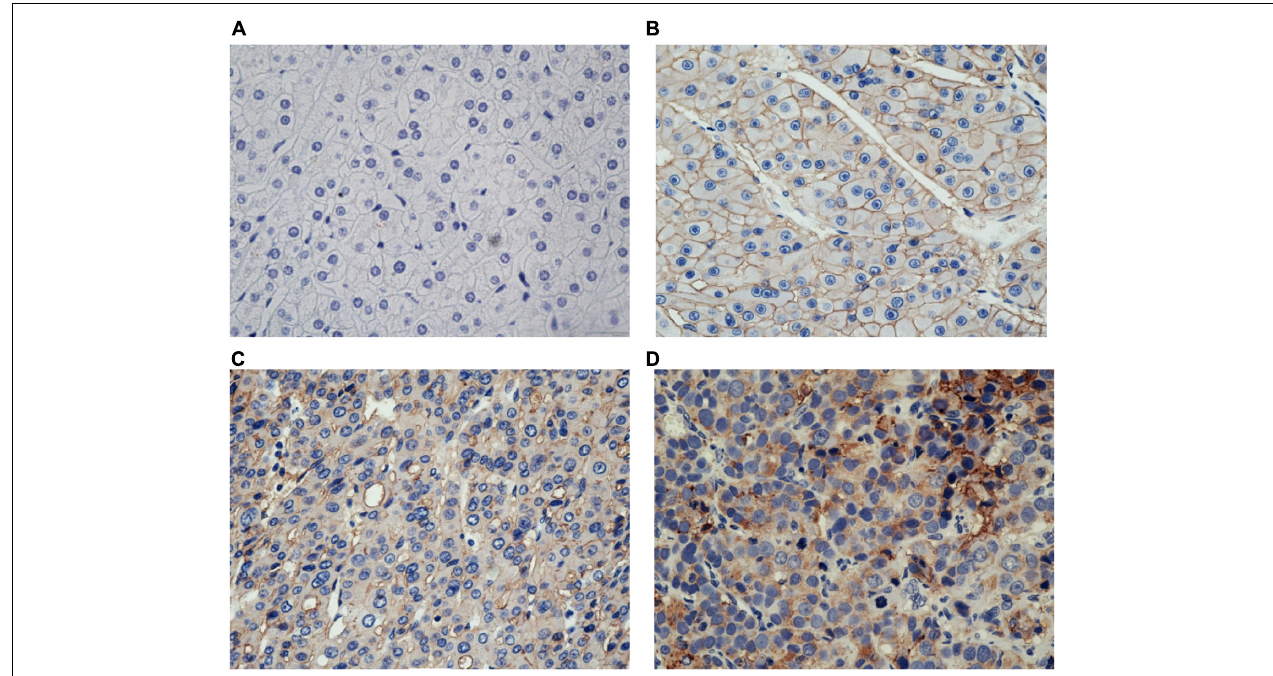
FIGURE 10 | Immunostaining of SCARB1 in HCC or the control tissue. (A) Negative staining of SCARB1 in normal tissue adjacent to HCC (400 magnification); (B) Positive staining of SCARB1 in well differentiated HCC tissue (400 magnification); (C) Expression of SCARB1 in moderate differentiated HCC tissue (400 magnification); and (D) Expression of SCARB1 in poor differentiated HCC tissue (400 magnification). SCARB1 = scavenger receptor class B member 1.